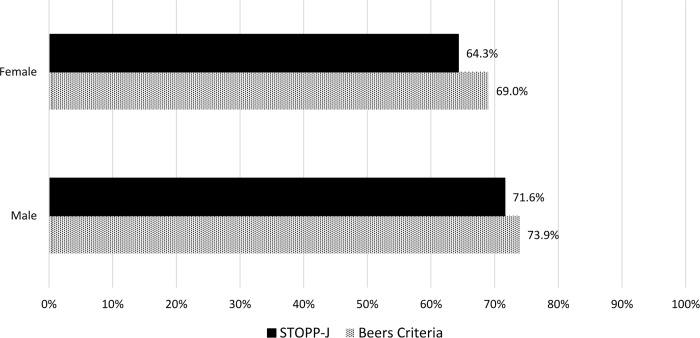
Proportion of PIM use by sex.